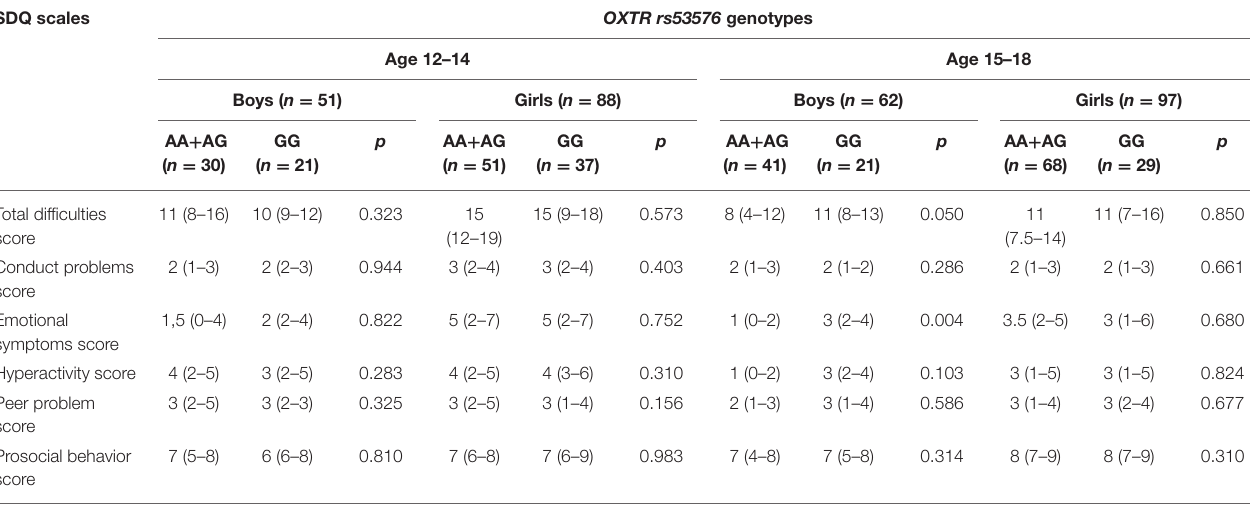
TABLE 4 | Values of the SDQ scales for the OXTR rs53576 genotypes in different sex and age groups of adolescents. SDQ